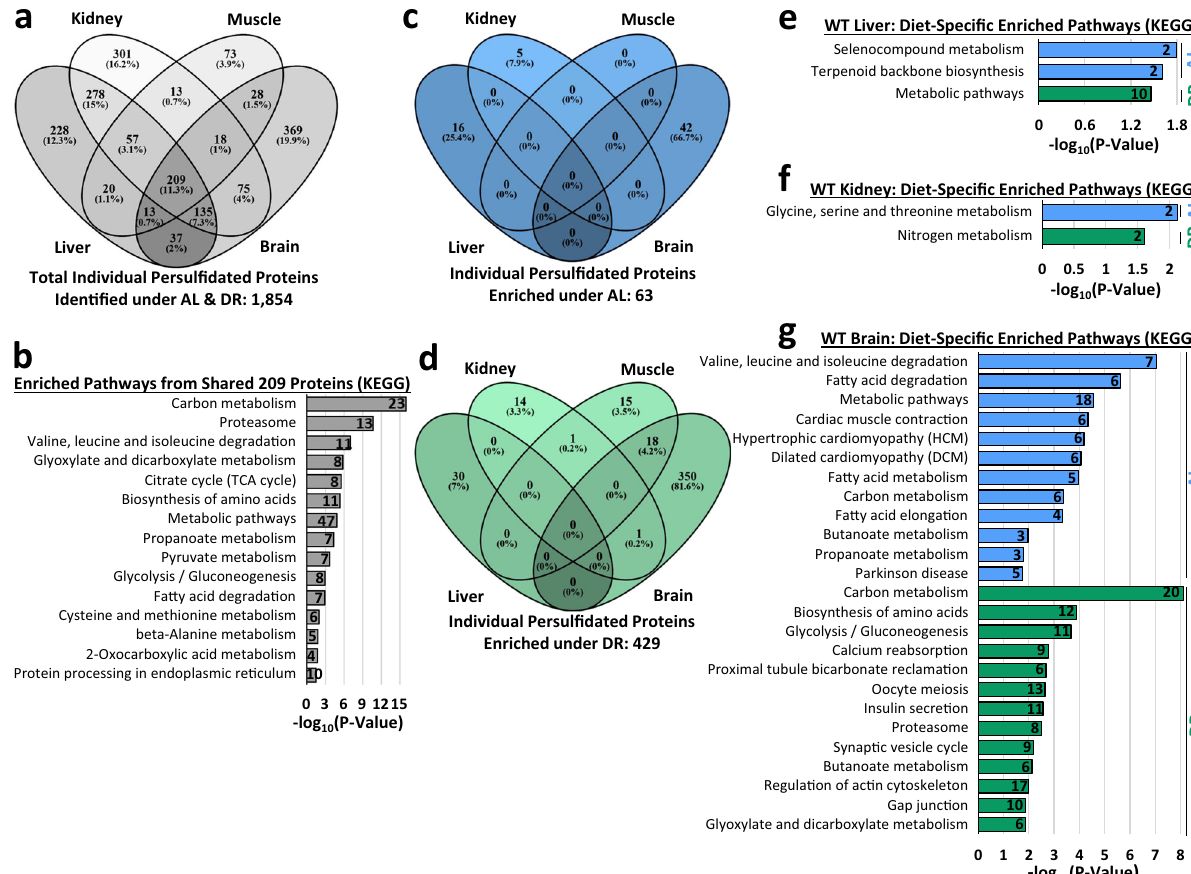
Fig. 3 Multiple pathways enriched with persul fi dated proteins dependent on diet and organ. a Four-way Venn diagram showing the number of shared and non-shared persul fi dated proteins identi fi ed in liver, kidney, muscle, and brain in cystathionine γ -lyase (CGL) wildtype (WT) mice. A total of 209 persul fi dated proteins were shared amongst all four organs. n = 9 mice total; 4/AL group and 5/DR group. b KEGG biological function and pathway enrichment of the shared 209 proteins found in liver, kidney, muscle, and brain via g:Pro fi ler analysis. c , d Four-way Venn diagrams showing shared and non-shared persul fi dated proteins enriched under AL ( c ) and DR ( d ) feeding. e – g KEGG biological function and pathway enrichment of AL enriched (blue bars) or DR enriched (green bars) persul fi dated proteins in liver ( e ), kidney ( f ), and brain ( g ). The numbers within the bars indicate individual persul fi